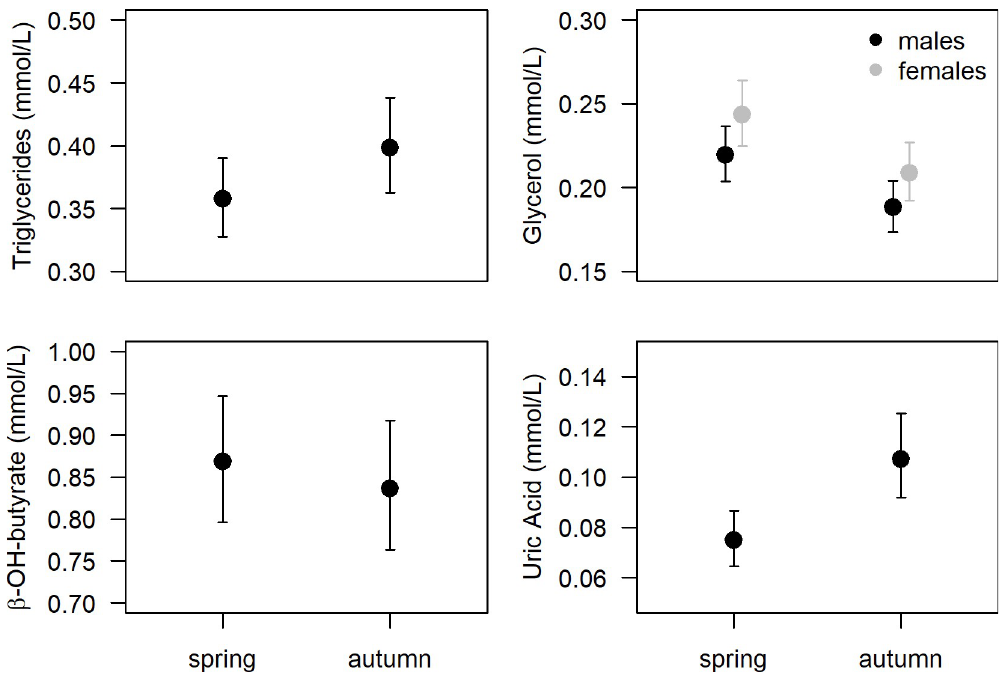
Fig 2. Plasma metabolite concentrations of dunlins sampled at the Tagus estuary during spring (n = 62) and autumn (n = 53–55) migration. Data (mean ± confidence intervals of the mean) are predictions from the selected model (see Table 2) where significant covariates were set with a constant mean value. For glycerol, predictions are presented for males and females separately, as sex was retained in the final model. Glycerol and uric acid concentrations were significantly higher and lower in spring than in autumn migrants, respectively (see